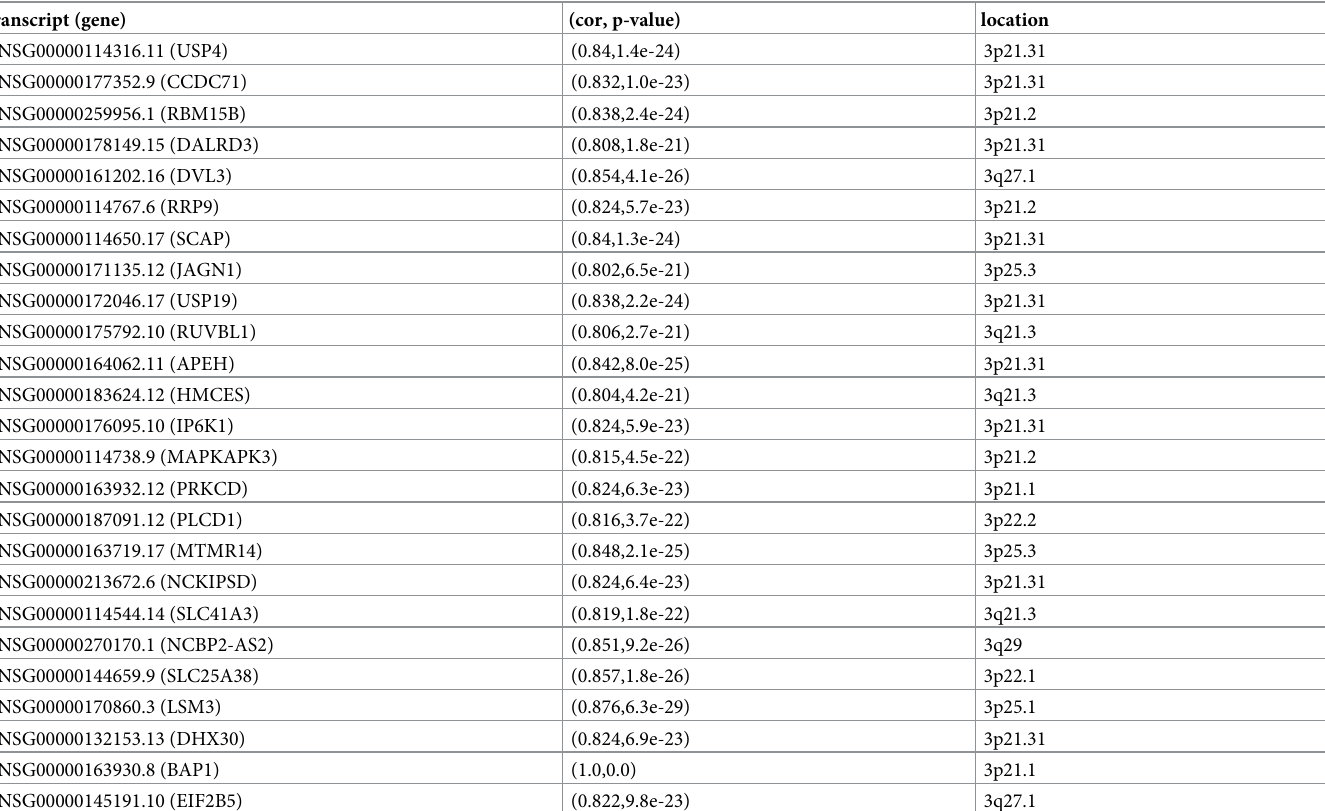
Table 4. Highly correlated genes with BAP1 in the entire UVM